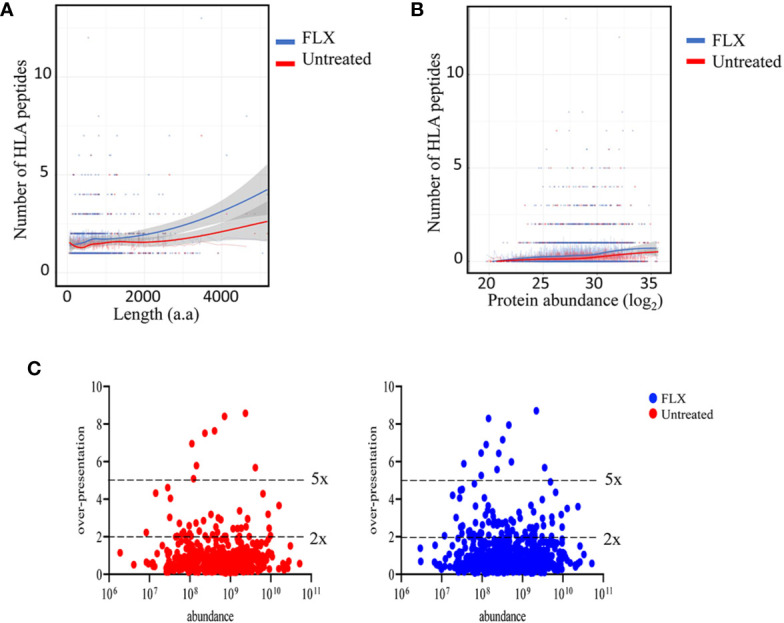
Flucloxacillin (FLX) treatment promotes a higher peptide sampling rate of proteins, independently of the length and abundance of the polypeptide. Abundance of human leukocyte antigen (HLA) peptides from 435 and 699 proteins in the proteome of B721-5701 cells untreated or FLX-treated, respectively, as a function of the protein amino acid length (A) or abundance (log2) (B). Individual proteins and trendlines are represented in the graphs. (C) Protein fold over-presentation was calculated based on the ratio between observed (D) and expected (D’) peptide density, and represented as function of protein abundance. The dataset of the represented proteins is provided in
Table S3
.